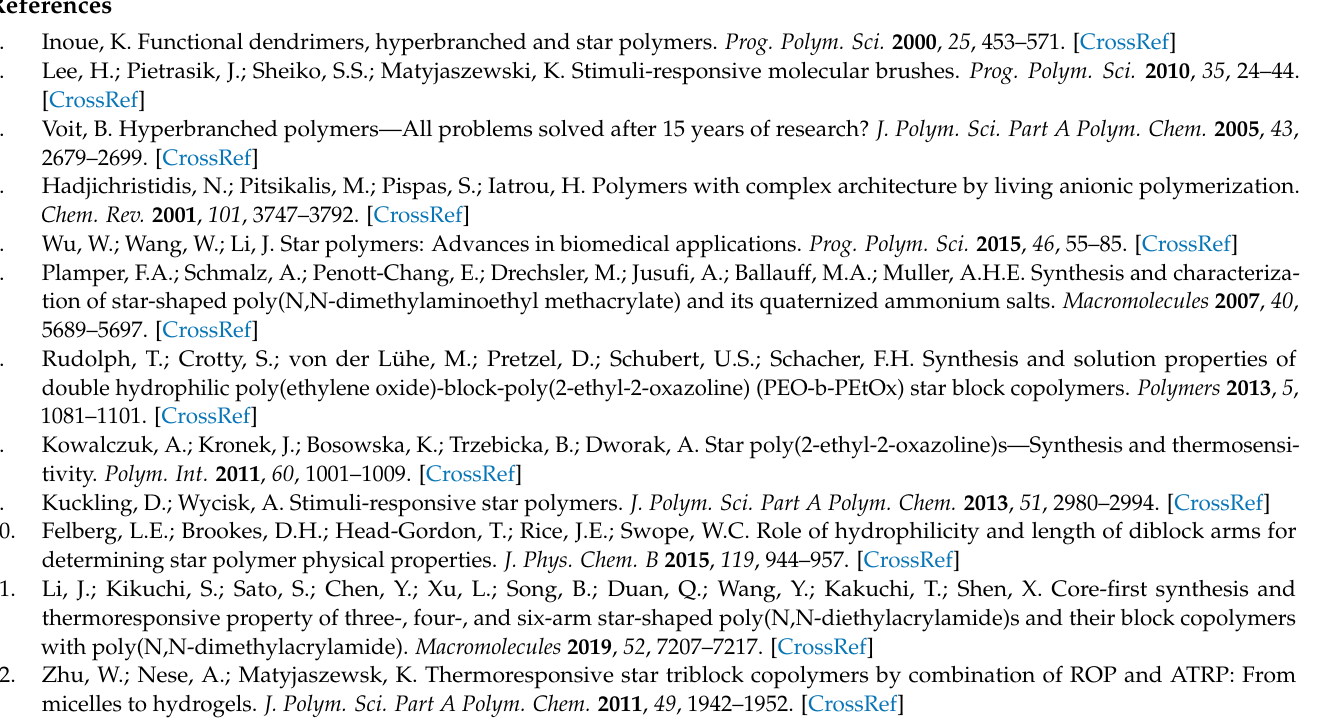
stars in 2-nitropropane. Figure S2: Concentration dependencies of dn for the C8A-PaOx solutions 2- nitropropane. Figure S3: Reduced viscosity η sp / c vs. c for the studied polymer stars in 2-nitropropane. Figure S4: UV–visible spectrum of the star-shaped C8A-(PEtOx-b-PiPrOx)-UR solution in ethanol. Polymer concentration is 0.005 g · cm − 3 . Figure S5: GPC traces of star copolymers CA8-PAlOx. Figure S6: Time dependencies of light scattering intensity I / I 0 and the transmission I */ I 0 * for solutions C8A-PAlOx. I 0 and I * 0 are values of light scattering intensity and the optical transmission at t =